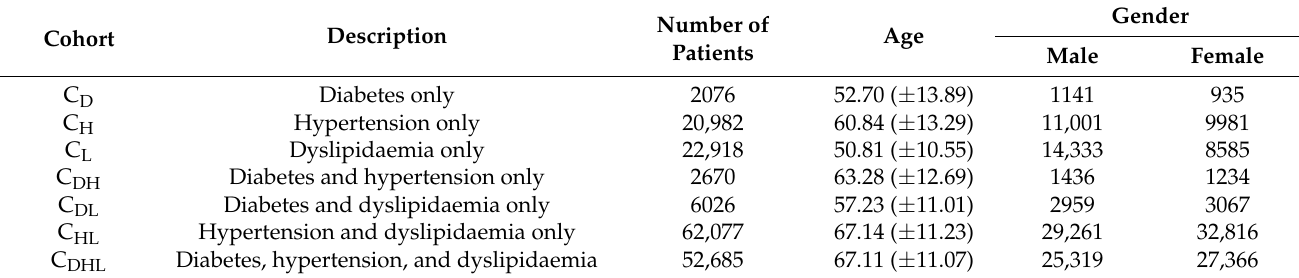
Figure 1. Derivation of the study cohorts ( n denotes the number of patients and m denotes the number of patients with macrovascular complication). Table 1. Baseline characteristics of patients in each study cohort.